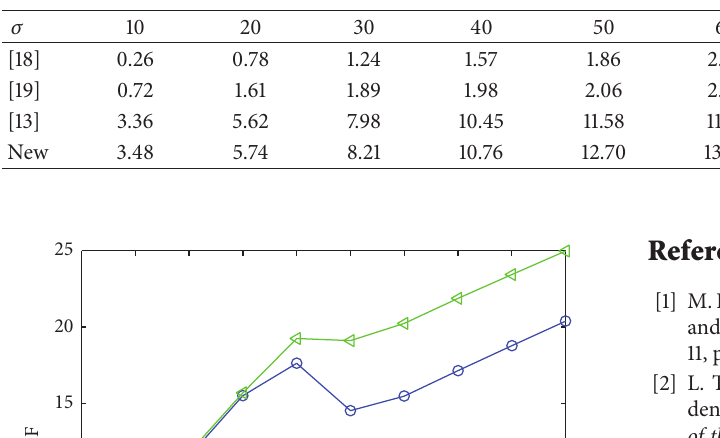
Table 9: IEF of different algorithms with different Gaussian noise levels for Bus video sequence.